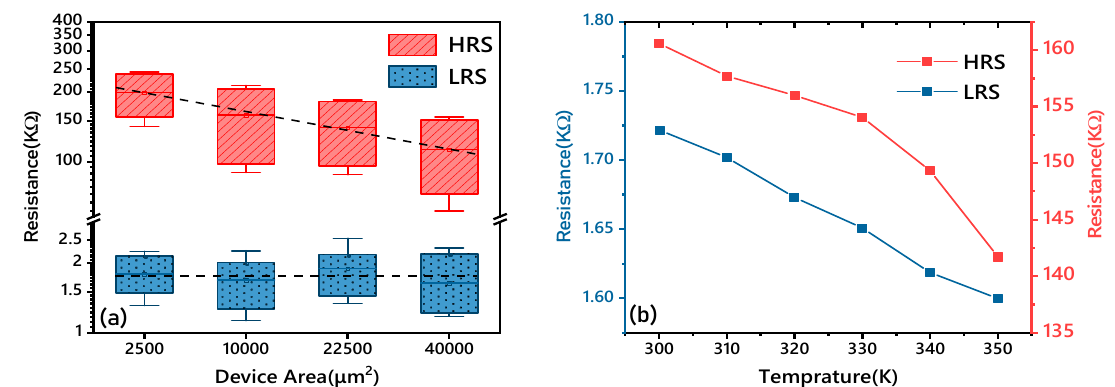
Figure 7. ( a ) Area dependence of resistance; ( b )Temperature dependence of resistance.